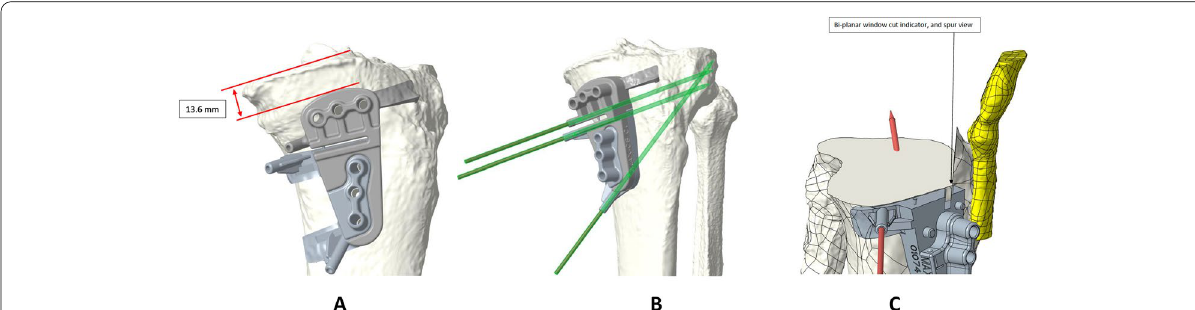
Fig. 3 Intraoperatively, the PSI guide was fixed with three K-wires ( A performing the osteotomy, the cutting guide is divided and the biplanar cut can be performed ( C )